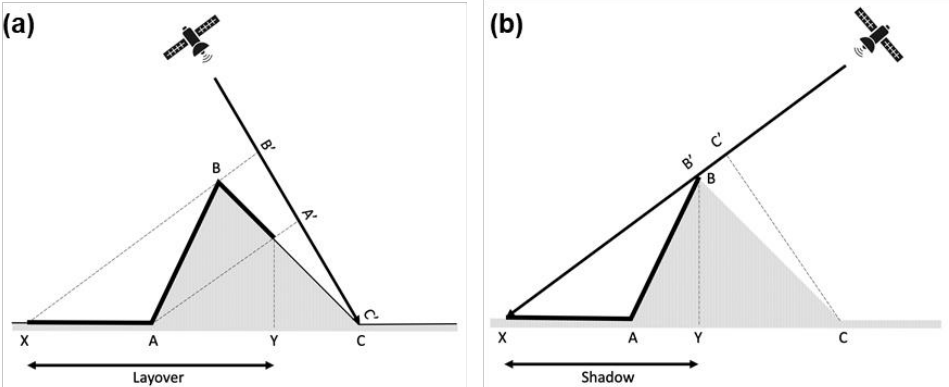
Figure 2. ( a ) Layover occurs in areas of steep topography when the peak of a feature (B) is actually closer to the radar than features on the slopes. This can result in a large area where reflections are superimposed (shown as a thick black line); in this scenario, the ground area between X and Y will all fall in layover. ( b ) Shadow occurs when the topographic feature blocks the radar signal from reaching areas on the backslope of a feature; in this scenario, the ground area between X and Y would be in shadow.